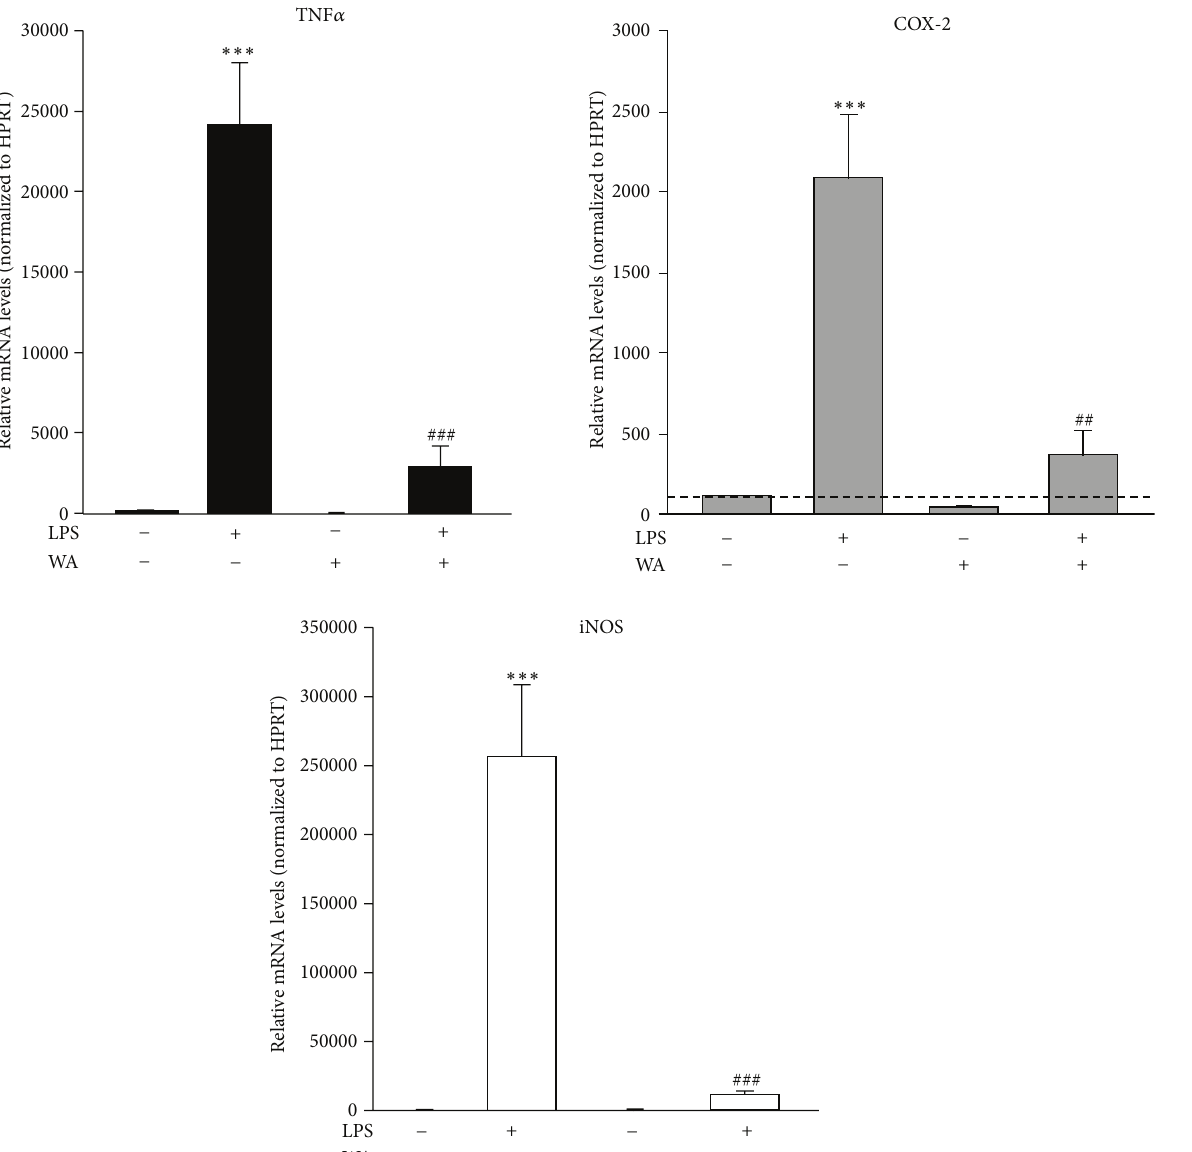
in models of neurodegenerative disorders deserves to be